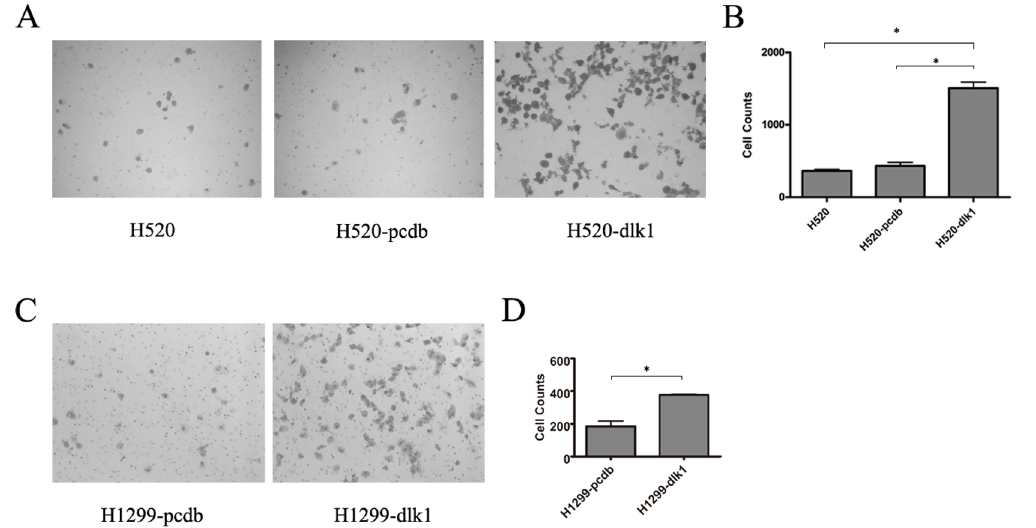
Figure 1. Effect of DLK1 overexpression on ECM invasion by the human lung cancer cells H520 and H1299 in an in vitro chemoinvasion assay. A, representative photomicrographs of the invading cells that migrated through the Matrigel-coated membrane of the transwell, taken from three groups: H520, the parental cells, H520-pcdb, the null vector-control cells and H520-dlk1, the cells stably expressing DLK1. B, a histogram for the counts of migratory cells from the H520, H520-pcdb and H520-dlk1 groups. C, representative photomicrographs showing H1299 cells, which were transiently transfected with DLK1 (H1299-dlk1) or null vector (H1299-pcdb), that invaded through the Matrigel-coated membrane of the transwell. D, a histogram for the counts of migratory cells from the H1299-dlk1 and H1299-pcdb groups. The experiments were performed in triplicate (* t-test, p-value , 0.05).